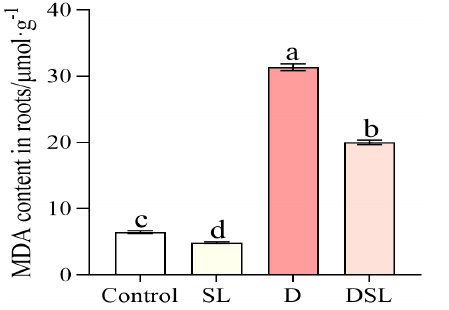
Figure 4. MDA contents of alfalfa root in response to different treatments. Results are presented as the mean of four independent experiments ± standard error. a–d Different superscripts mark significant differences between the treatments ( p <